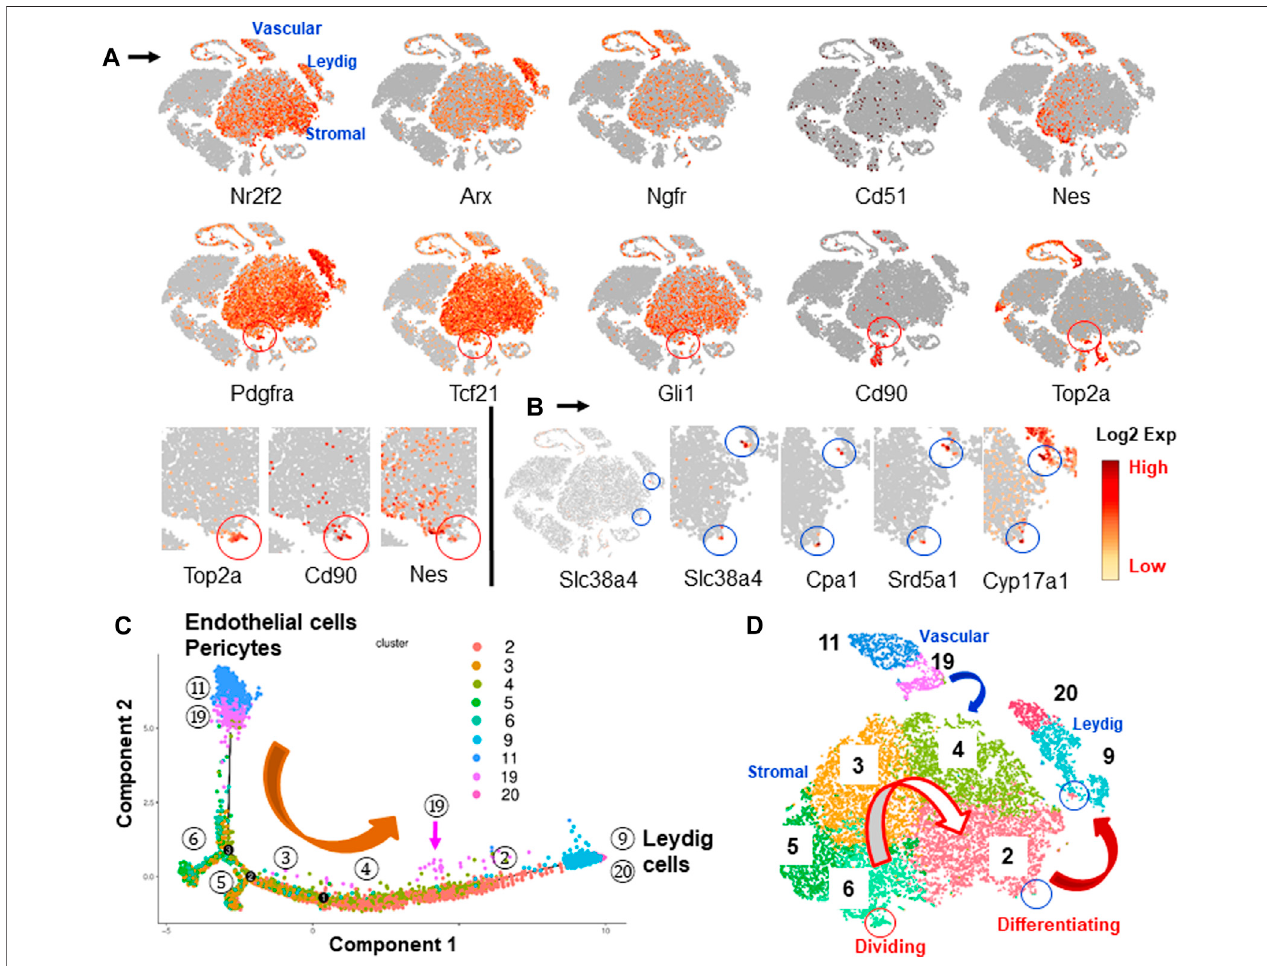
FIGURE 4 | Identi fi cation and characterization of potential SLCs in the interstitial cells. (A) Distributions of nine SLC markers reported previously by various researchers. Cd90 and Nes concentrated in the area containing dividing cells (Top2a, red circle). (B) PLC/ILC markers (Slc38a4, Cpa1 and Srd5a1) and LC marker (Cyp17a1) highlighted two spots across the mesenchymal and Leydig cell clusters (blue circle), suggesting the developmental bridges between the two cell types. (C) Pseudotime trajectory ofvascular and mesenchymal cell populations shows thedevelopmental sequence if they were involved inLC formation. (D) Developmental relationships among the potential LC precursors summarized from marker genes and pseudotime trajectory.